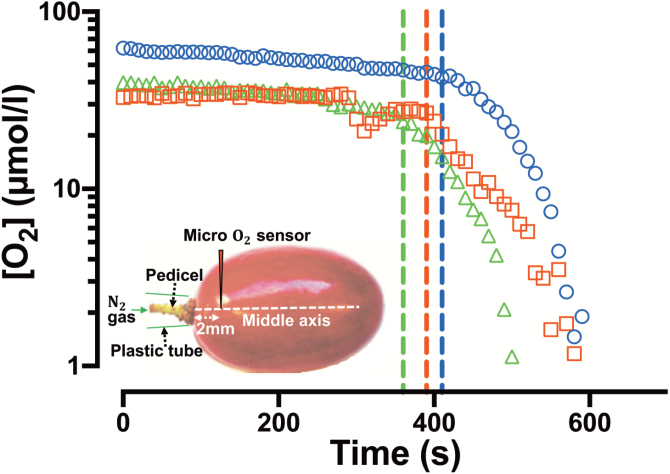
The role of the pedicel in gas diffusion into Ruby Seedless grapes (132 DAA in the 2016–2017 season). [O2] of three individual berries as a function of time with the sensor inserted approximately at the central axis of Ruby Seedless ~2 mm from the pedicel. Dashed lines indicate the start of external N2 gas delivery over the pedicel. Different symbols indicate different berries. Inset: experimental set-up for applying N2 gas over the berry pedicel while measuring [O2].